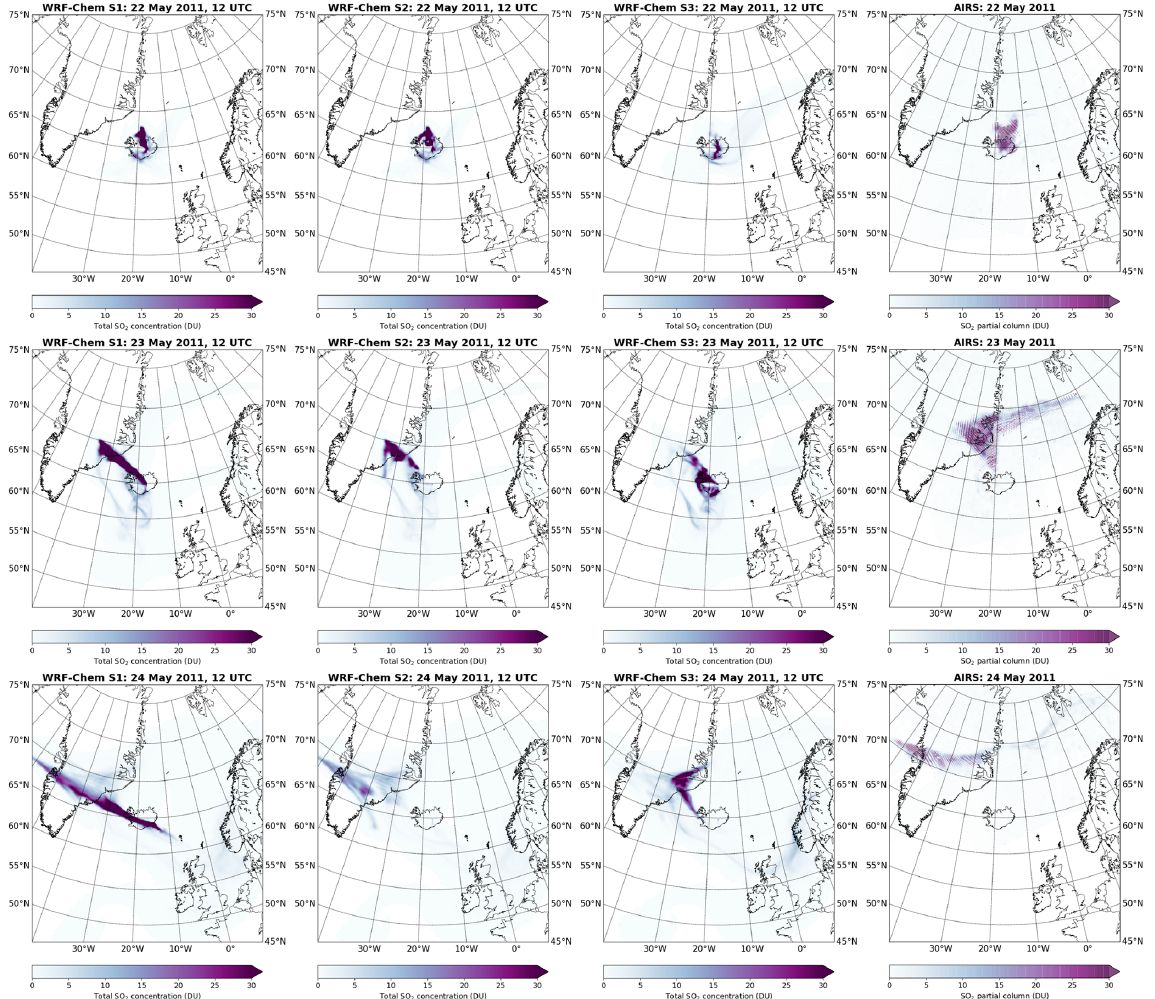
Figure A2. SO 2 total columns (DU) from WRF-Chem simulations (S1, S2, and S3) compared to the AIRS observations on 22 to 24 May